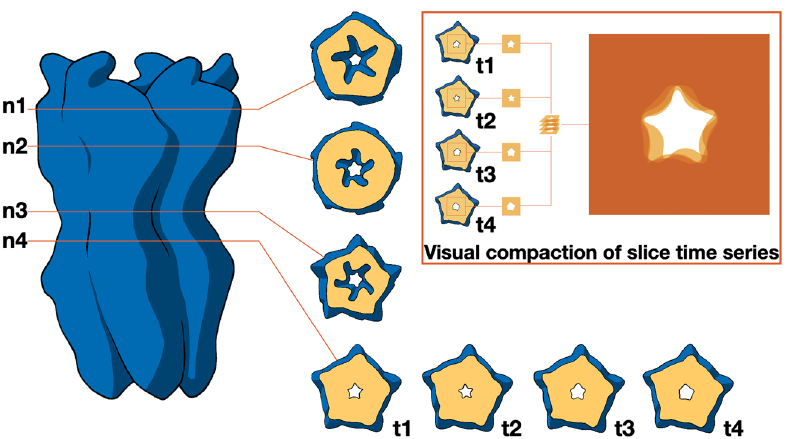
brane. The main constriction